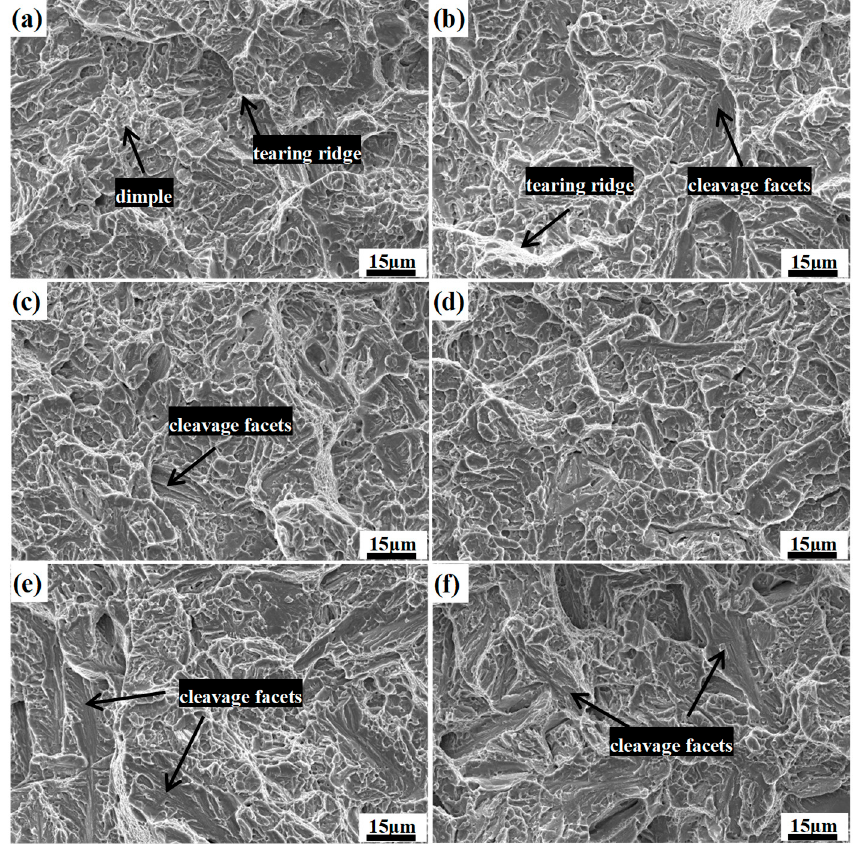
Figure 12. Microfracture morphology of fracture surface in different impact samples. ( a ) DIT; ( b ) QBT-